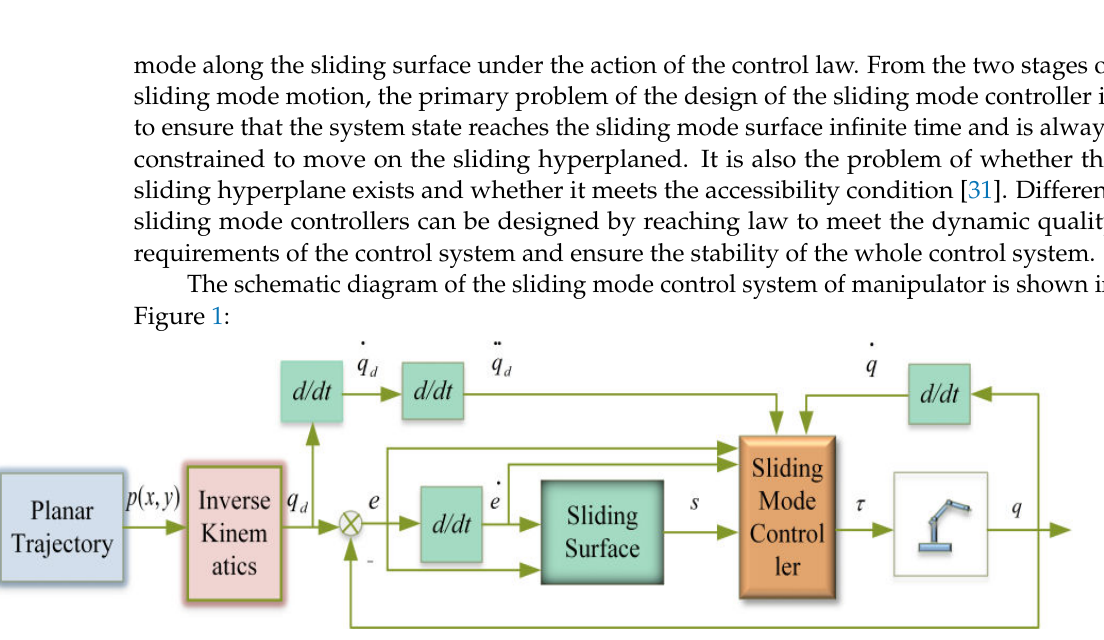
Figure 1. Schematic diagram of the sliding mode control system of the